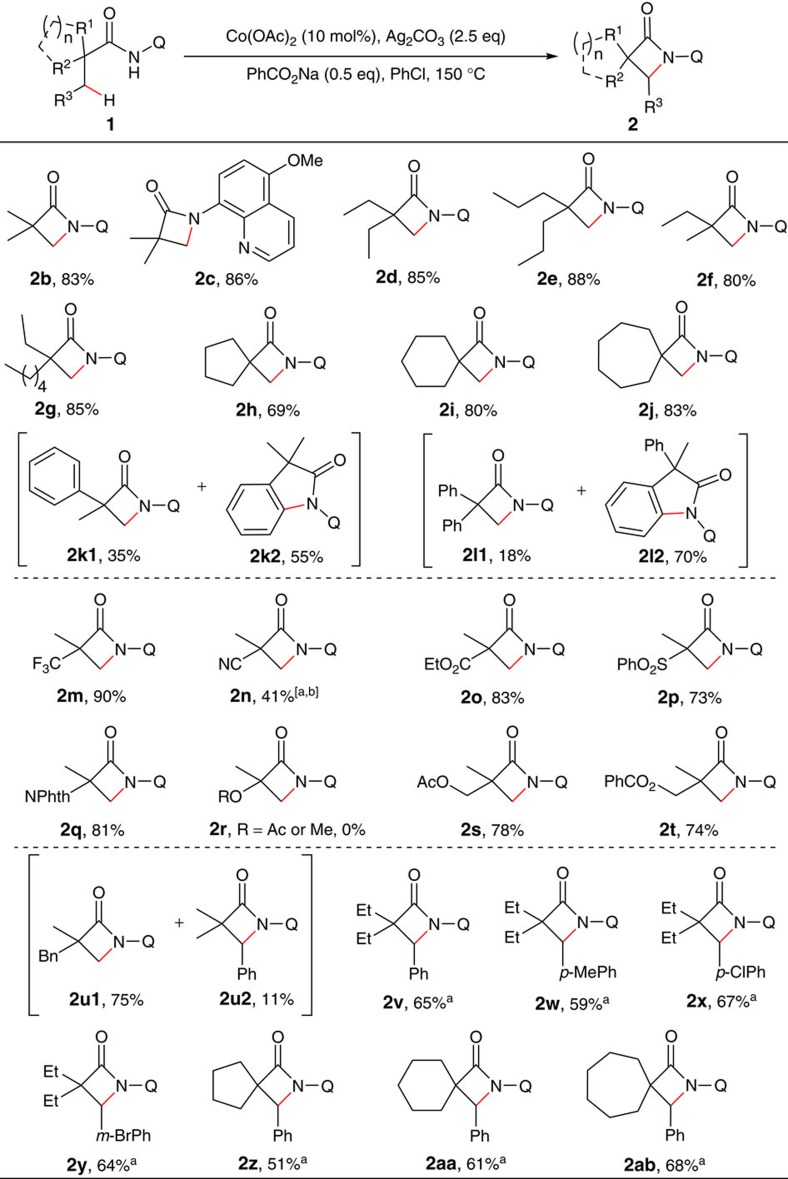
Scope of α,α-disubstituted propanamides.Reaction conditions: 1 (0.3 mmol), Co(OAc)2 (0.03 mmol), Ag2CO3 (0.75 mmol), PhCO2Na (0.15 mmol), 0.6 ml PhCl, 150 °C, 24 h. Isolated yield based on three runs of each reaction. aRun for 48 h. bCo(OAc)2 (0.06 mmol). Q=8-quinolinyl.